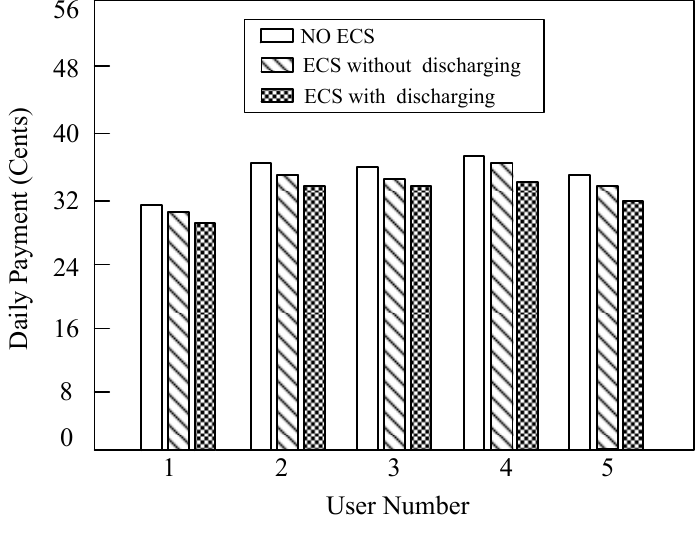
Figure 6. Daily electricity cost of each user having household appliances and/or a plug-in electric